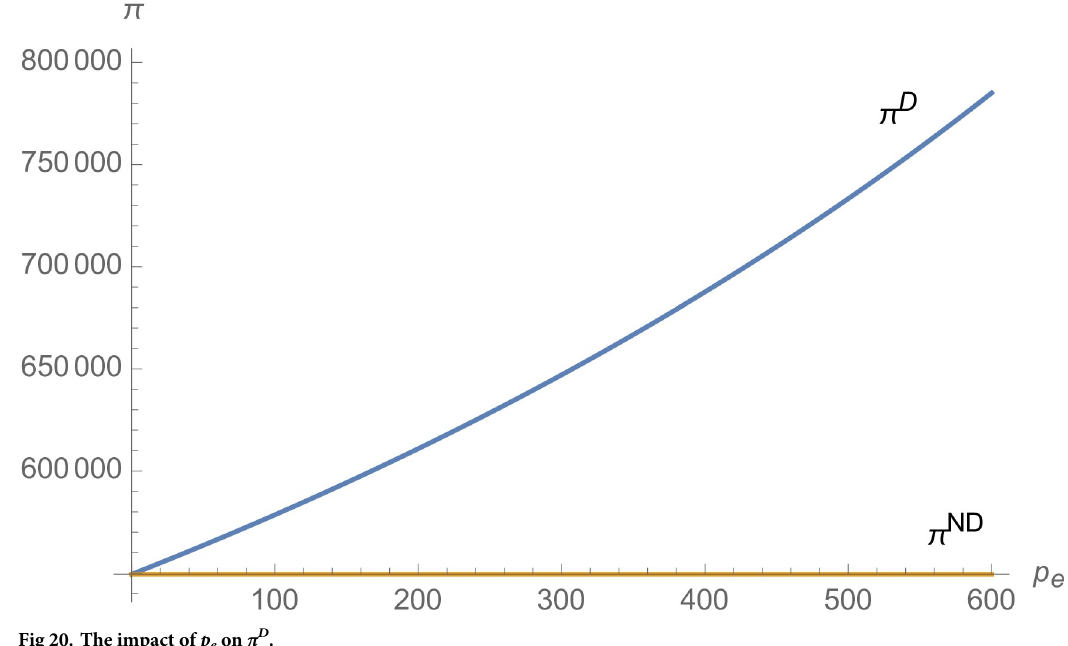
Fig 20. The impact of p